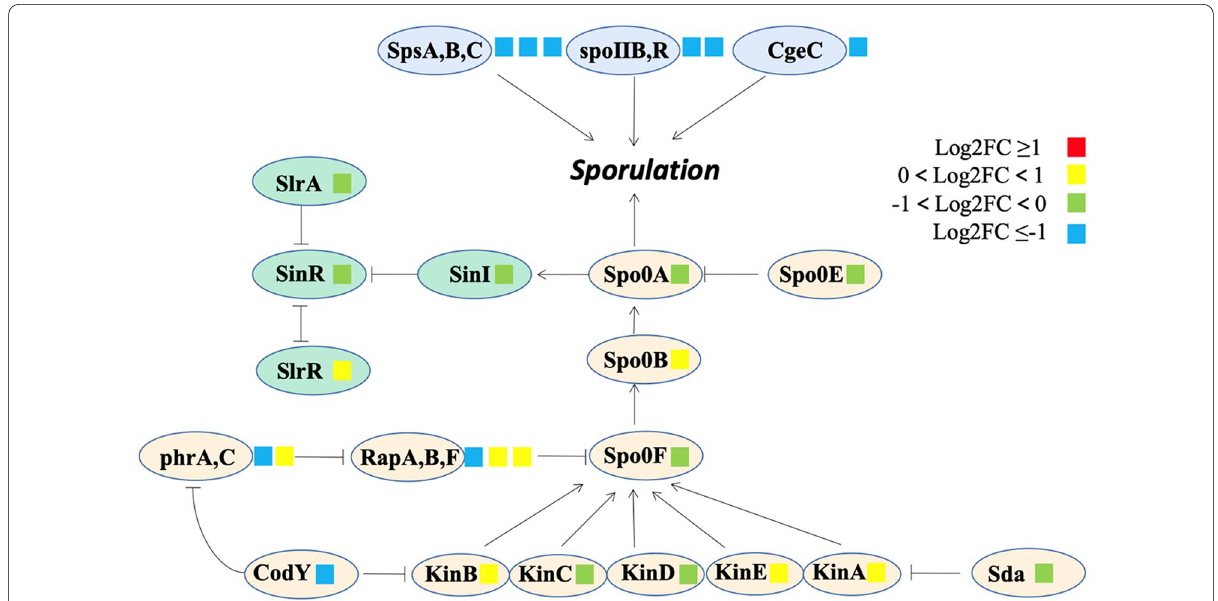
Fig. 4 Changes in transcript abundance of genes involved in sporulation in